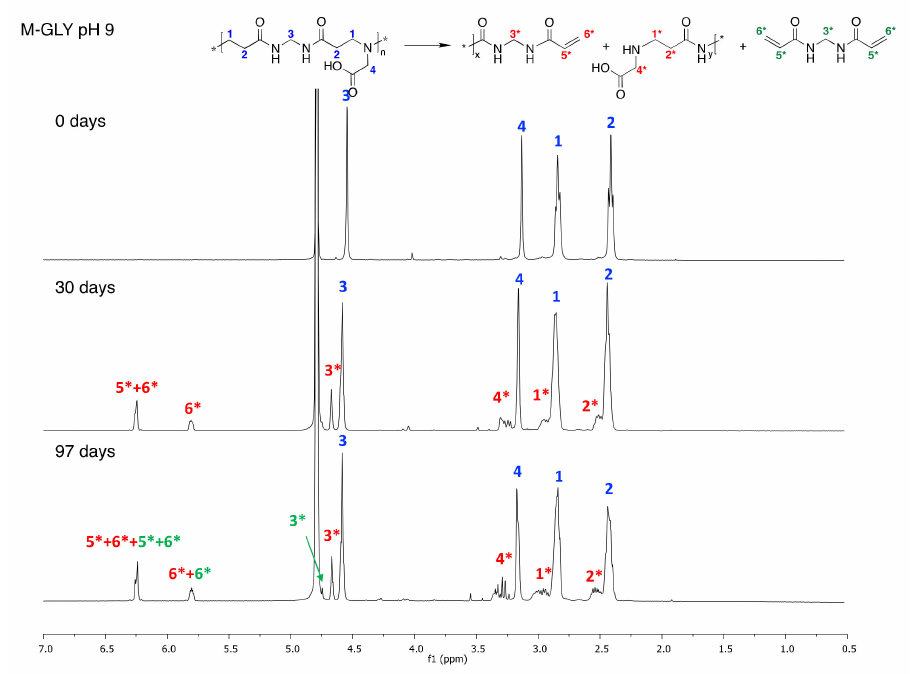
Figure 2. 1 H-NMR spectra of M-GLY obtained in D 2 O at pH 7.0 at different times using a 400 MHz Avance Brüker spectrometer. Concentration of the repeat unit 43.6 µ M. Degradation percent calculated both as [H 3* / (H 3 + H 3* )] × 100 and as {[(H 5* + H 6* ) / 3] / [(H 2 + 2H 2* ) / 4]} × 100, where H n stands for the integral of the resonance peak of the hydrogen indicated in the subscript.